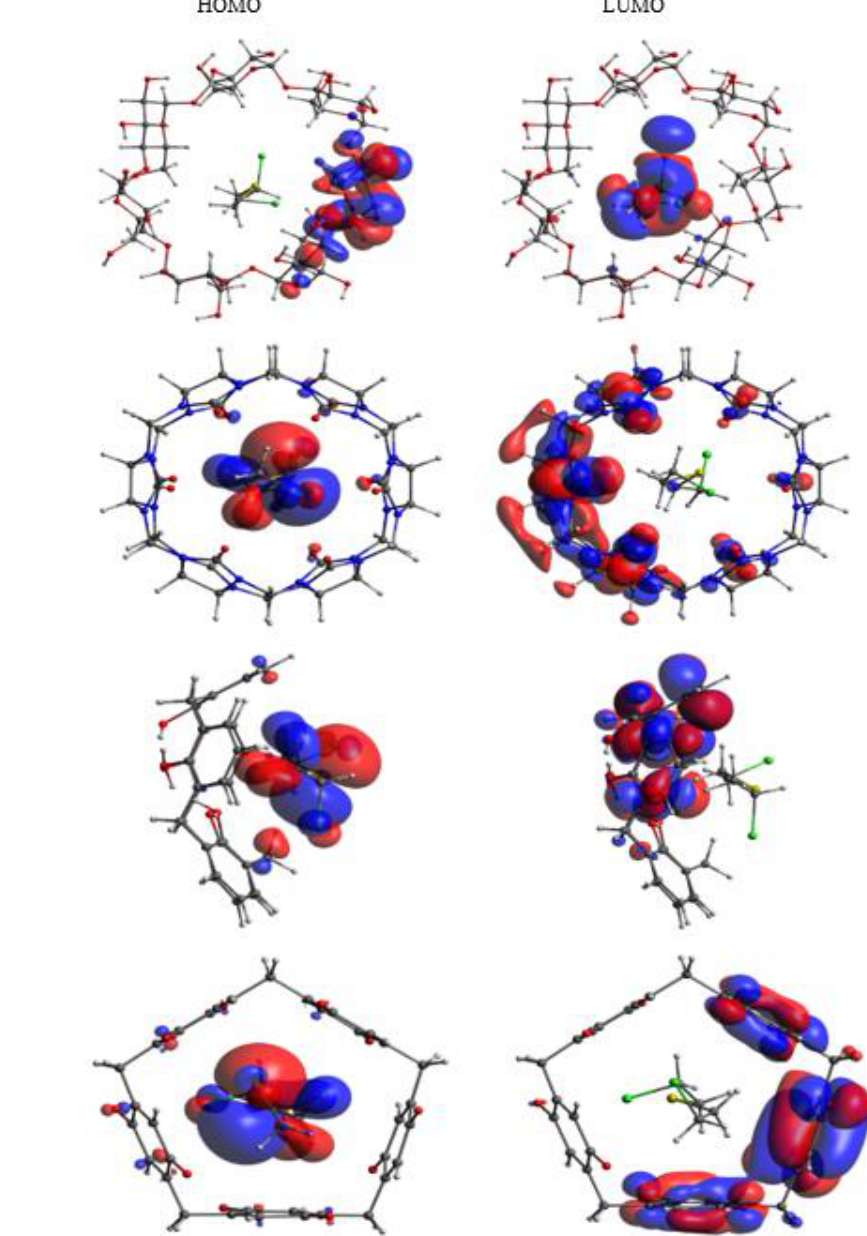
Figure 5. The frontier molecular orbitals (HOMO and LUMO) of SM@ β -CD, SM@CB[6], SM@CX[5], and SM@P[5]Q obtained from r 2 SCAN-3c gas-phase calculations. Atom colors: chlorine (green); oxygen (red); carbon (grey); sulfur (yellow); nitrogen (blue) and hydrogen (white). The HOMO and LUMO of SM@P[5], SM@DAP[5], SM@MeP[5], and SM@DCMP[5] are presented in Supplementary Figure S2.